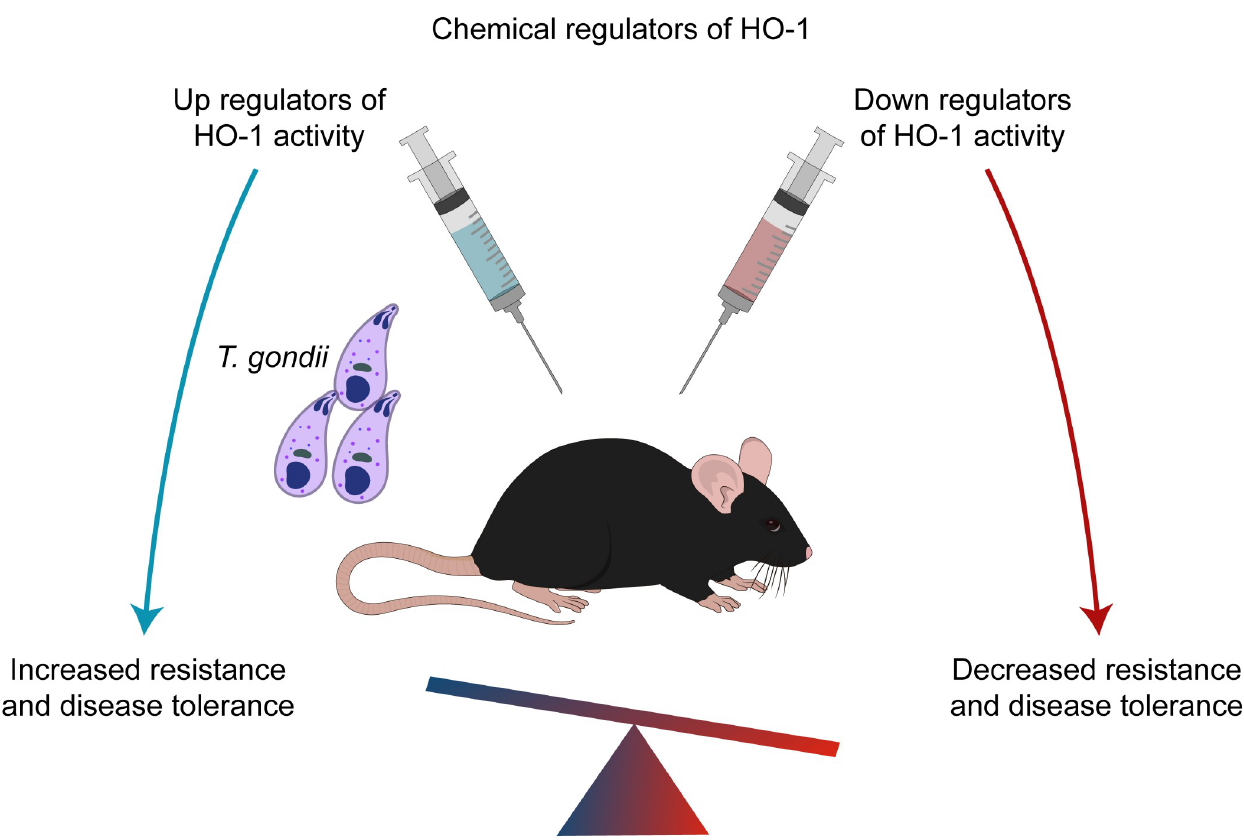
Fig 4. HO-1 on toxoplasmosis. In mice pretreated with chemical regulators of HO-1, induction of HO-1 expression decreases parasite burden on tissues and the morbidity of infected mice, while inhibition of HO-1 activity produced the opposite effect. This indicates that, in toxoplasmosis, HO-1 increases resistance and disease tolerance. HO-1, heme oxygenase